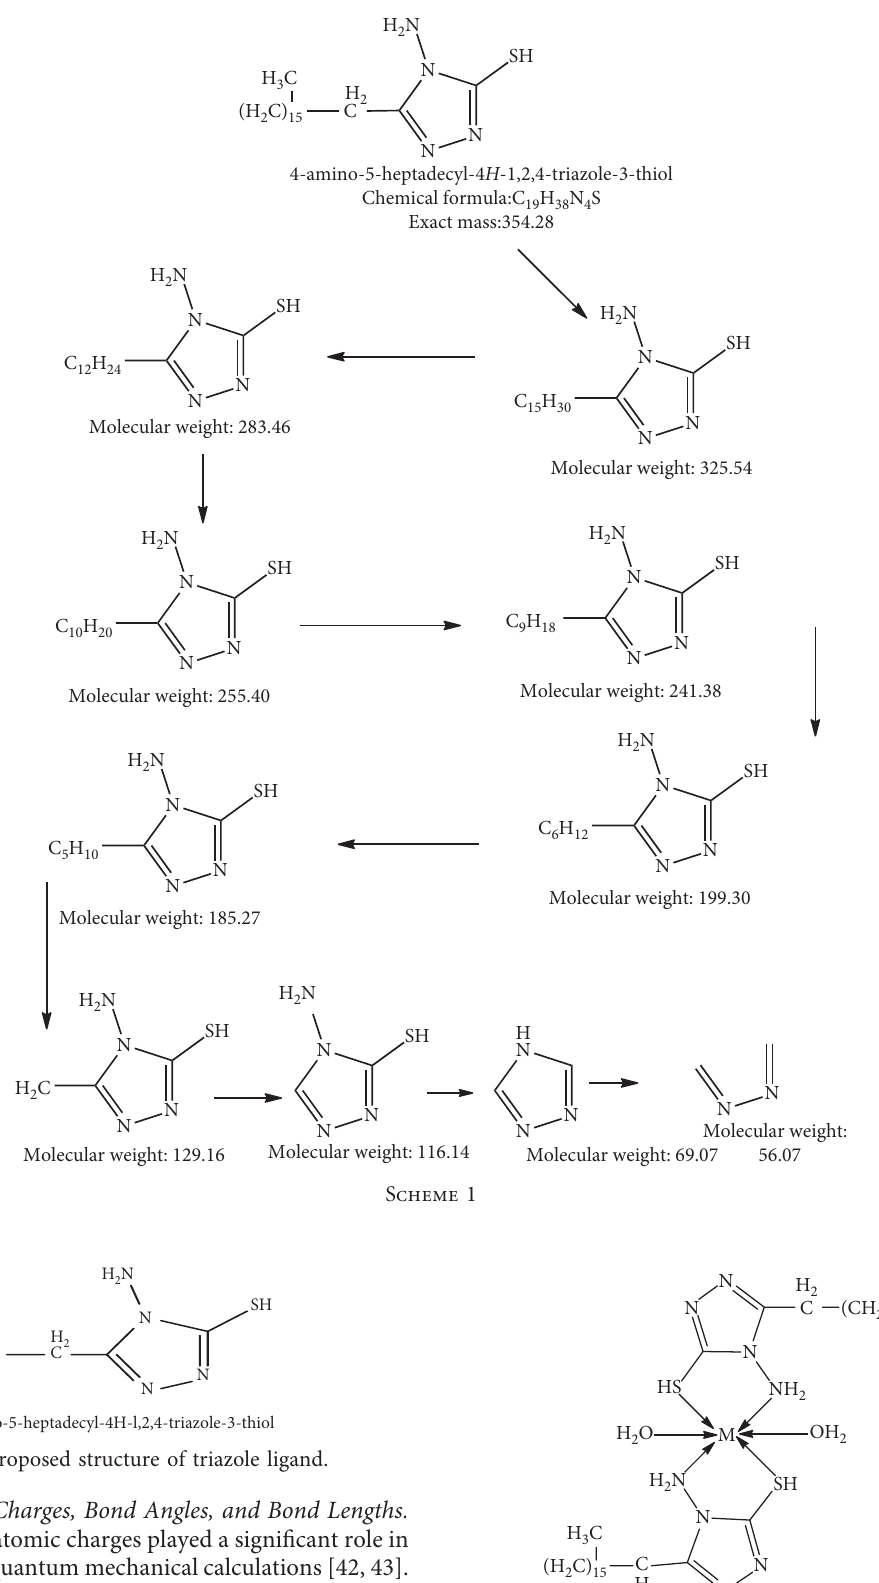
Figure 1: Proposed structure of triazole ligand.